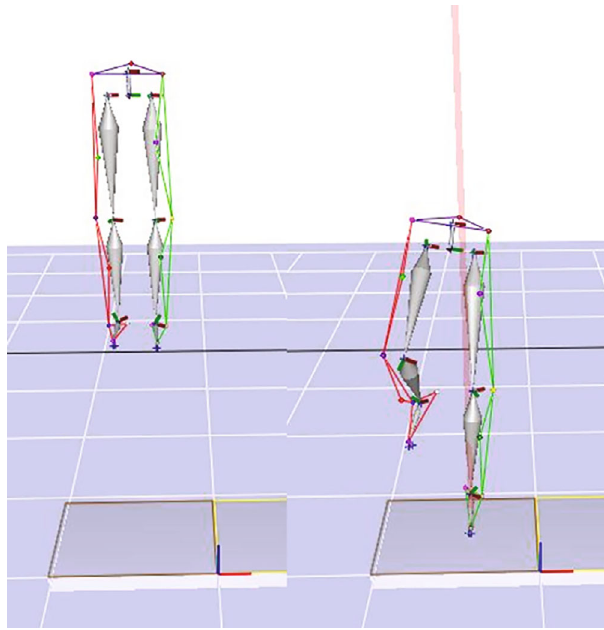
Figure 2: Point of maximum ground reaction force during single- leg drop